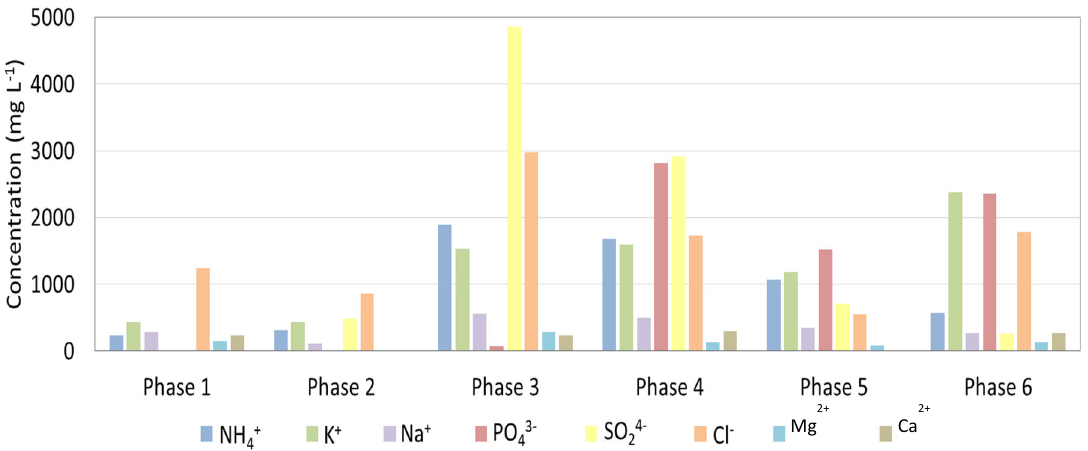
Figure 4. Composition of the main ions in the concentrated solution of the recovery compartment after each condition tested. Phase 1: not amended feeding was used; Phase 2: catholyte acidified to pH 6; Phase 3; catholyte acidified to pH 5; Phase 4: catholyte acidified to pH 5 and phosphate amended; Phase 5: phosphate amended catholyte; Phase 6: phosphate amended anolyte. Table 4. Estimation of the fraction of precipitated components on the recovery solution in each phase when adjusting the pH to 8. Phase 4: catholyte acidified to pH 5 and phosphate amended; Phase 5: phosphate amended catholyte; Phase 6: phosphate amended anolyte.